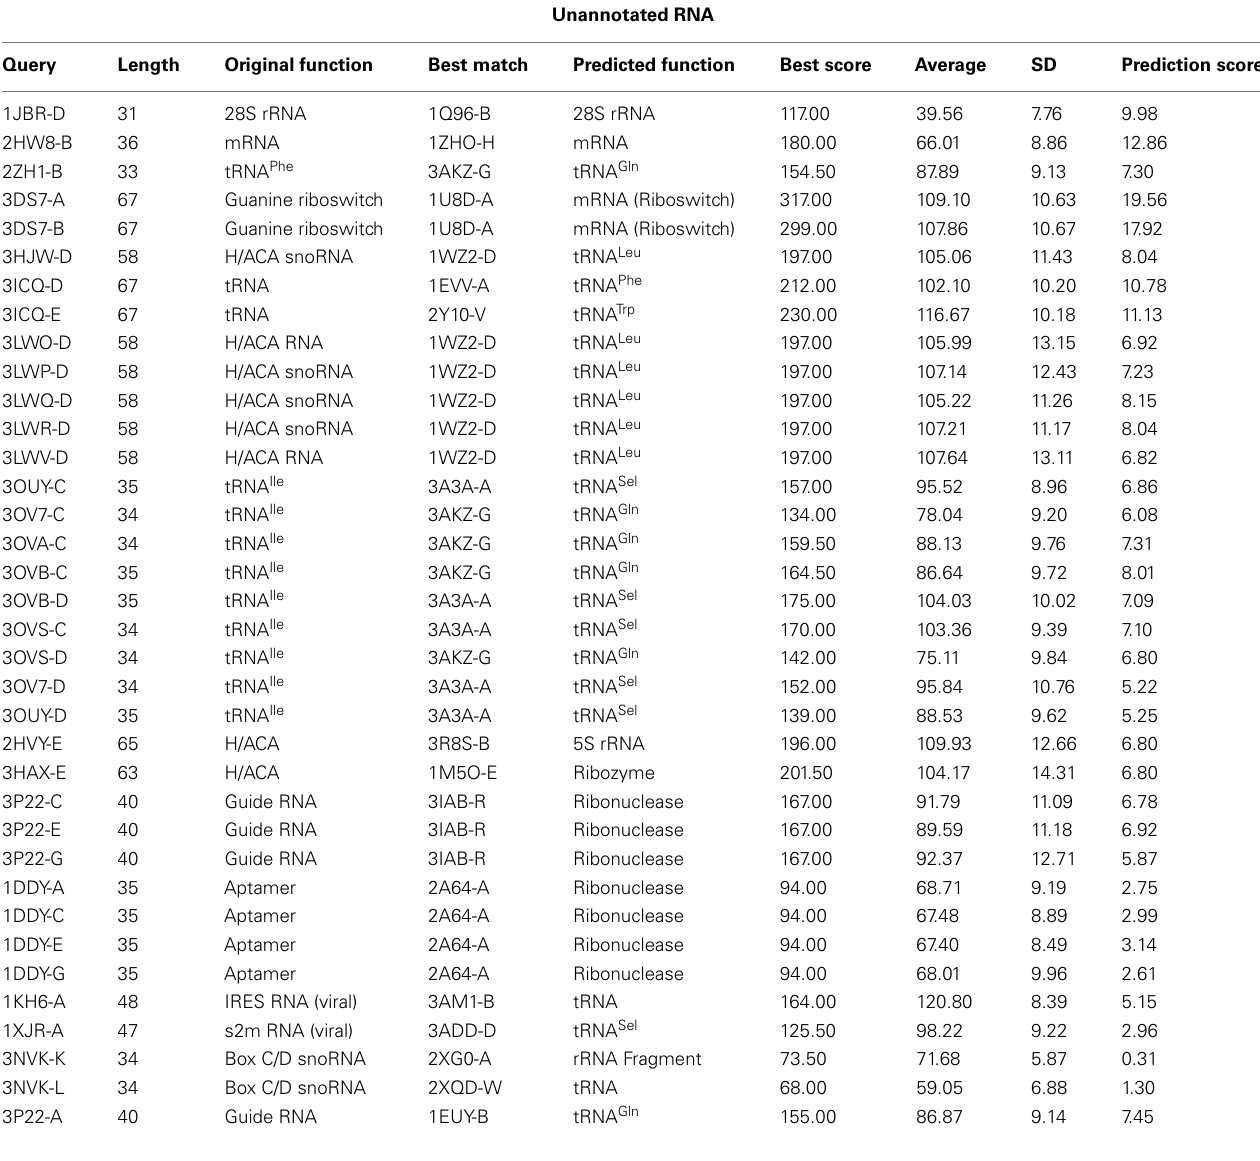
Table 5 | Function annotation to unannotated